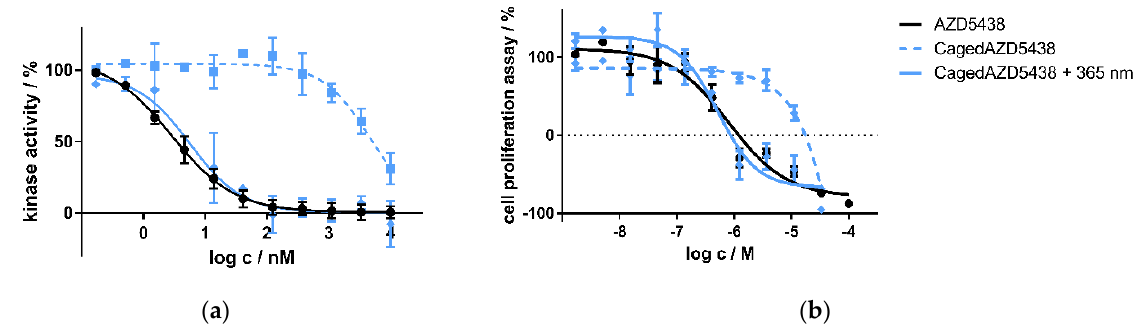
Figure 4. ( a ) Kinase assay of caged and uncaged AZD5438 using the target kinase assay CDK2/cyclin E1 with and without UV irradiation. CDK2 in complex with cyclin E1 was incubated with the inhibitor AZD5438 as well as its caged prodrug cagedAZD5438 to determine kinase activity. In a second setup, 10 min after compound addition both assays were irradiated with UV light for two minutes (365 nm, 37.5 mW). Data represent mean ± SD from two independent experiments, each performed in triplicate. ( b ) Cell proliferation assay of the inhibitor AZD5438 and cagedAZD5438 with and without UV irradiation using Panc89 cells. UV irradiation was performed for 2 min, 365 nm, 37.5 mW. Cell proliferation was determined after 48 h of drug treatment. Data represent mean ± SEM from three independent experiments, each performed in quadruplicate.